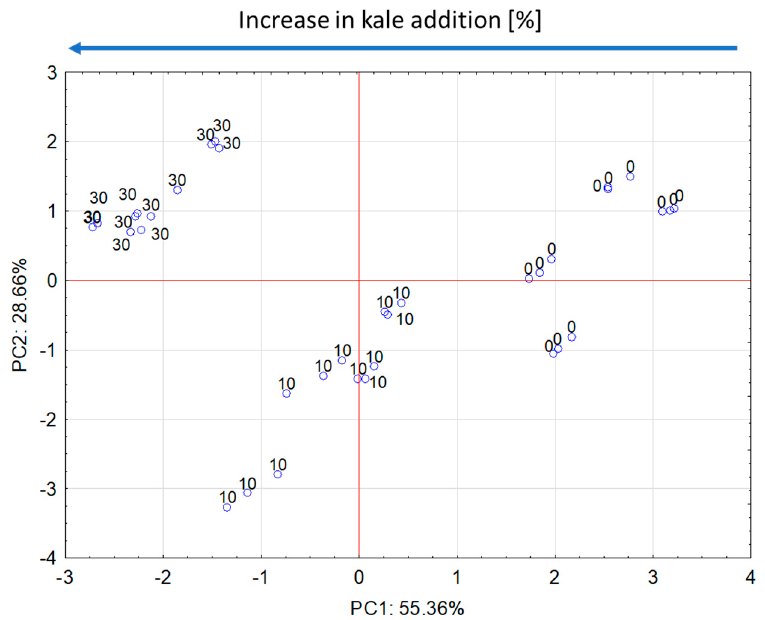
Figure 2. PC1 and PC2 loading plot. Projection of cases characterizing the level of fresh kale addition.